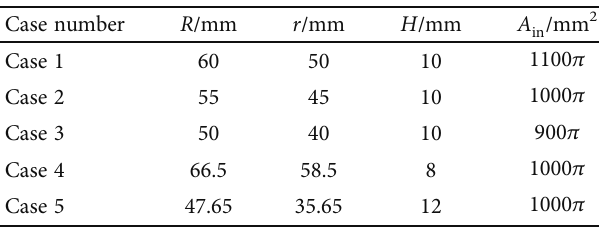
Table 2: Simulation conditions.